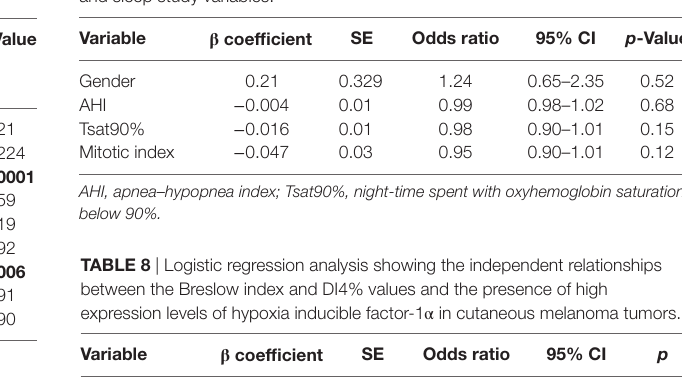
TaBle 7 | Logistic regression analysis illustrating the lack of independent relationships between VEGF expression and melanoma aggressiveness, gender, and sleep study variables.